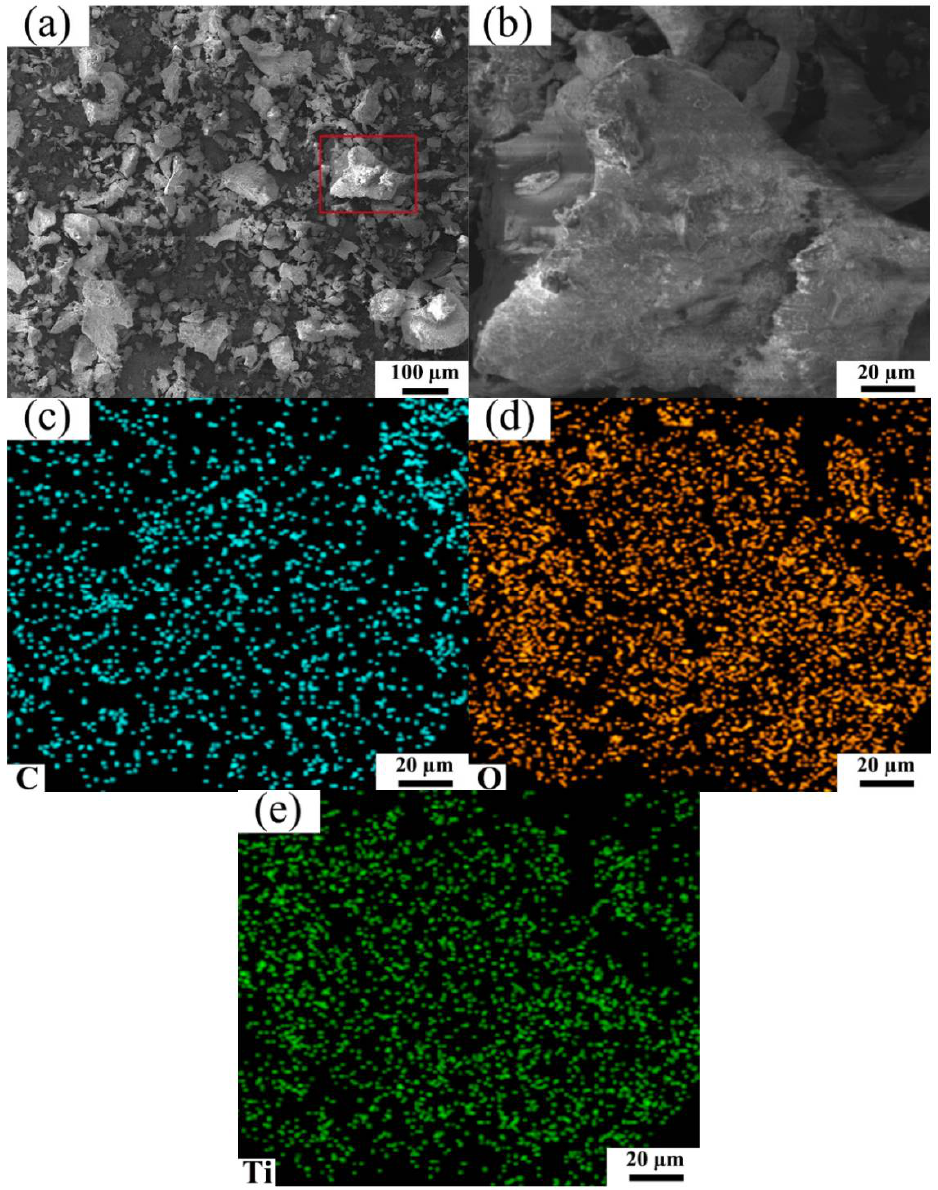
Figure 3. ( a ) low magnitude, ( b ) high magnitude SEM images of TCS powder; ( c ) C, ( d ) O and ( e ) Ti elemental mapping of ( b ).